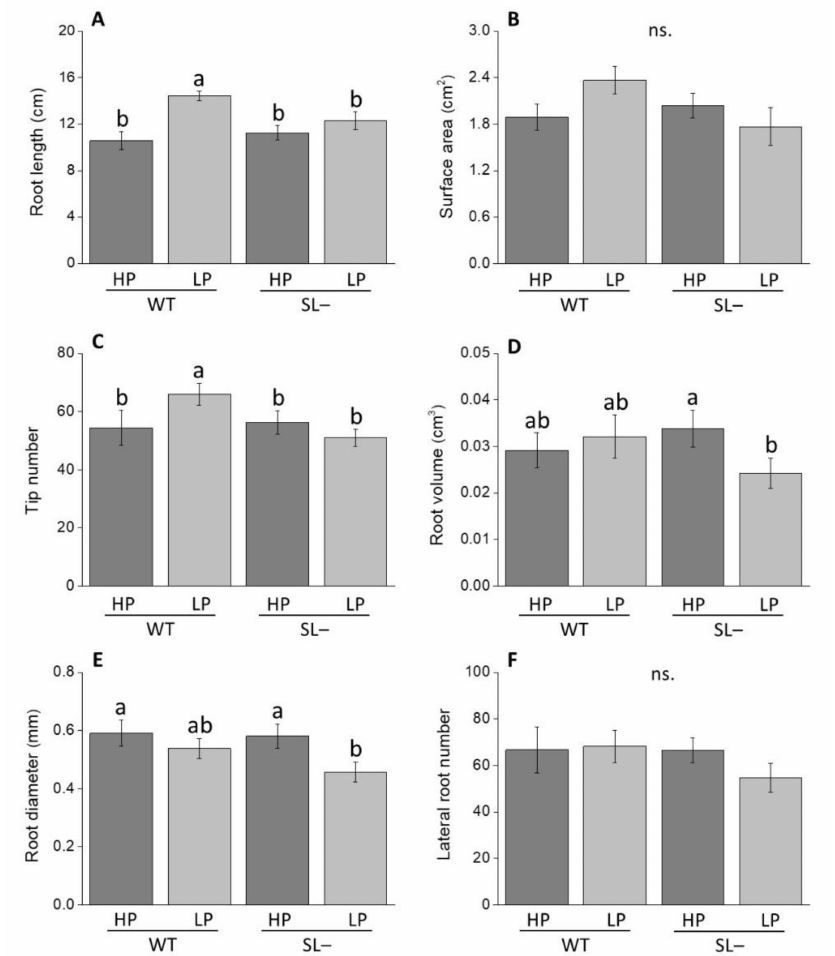
Figure 3. Root growth-associated parameters of wild-type (WT) and strigolactone-depleted plants (SL–) grown for 10 days in MS medium with either high P (HP) or low P (LP). ( A ) Root length; ( B ) surface area; ( C ) tip number; ( D ) root volume; ( E ) root diameter; ( F ) lateral root number. Data represent the means of 14 measurements per treatment ( ± SE) obtained via WinRHIZO. Di ff erent letters above bars indicate significant di ff erences between treatments ( p ≤